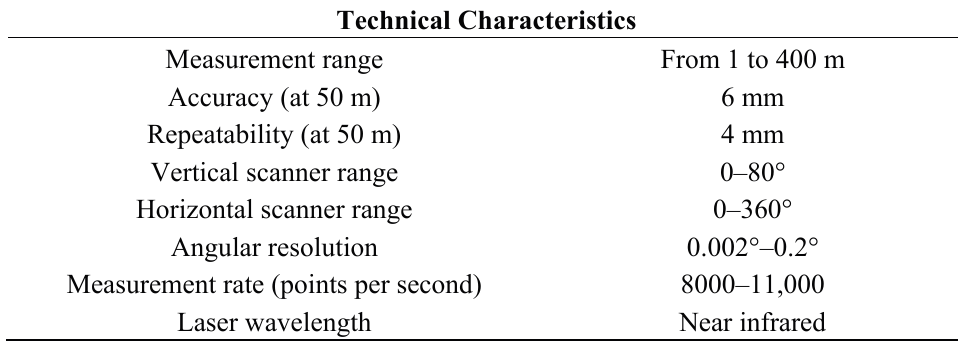
Table 1. Technical characteristics of the Riegl LMS Z-390i laser scanning device according to the manufacturer datasheet.